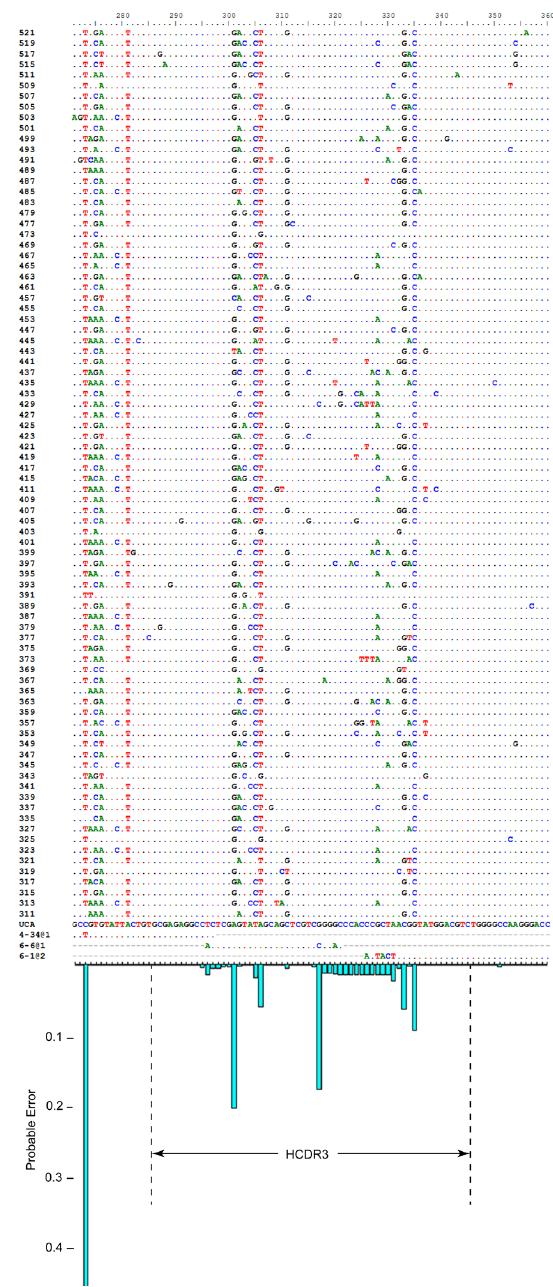
Figure 3. Nucleotide alignment and error profile. Nucleotide alignment of observed heavy-chain sequences, inferred unmutated ancestor, and modal gene segments, with the probable error (below), illustrating the influence of N nucleotides, junctions, and allelic ambiguity on uncertainty. The large probable error at position 273 is due to allelic ambiguity. A second position in FR1 has similar probable error due to allelic ambiguity (not shown). HCDR3 is indicated. The 84 sequences at the top of the alignment are fragments of the observed members of Clone H (naming is arbitrary). The 4 sequences at the bottom of the alignment are the modal unmutated ancestor (UA), and the modal gene segments. A dot in the sequence indicates a match to the UA at that